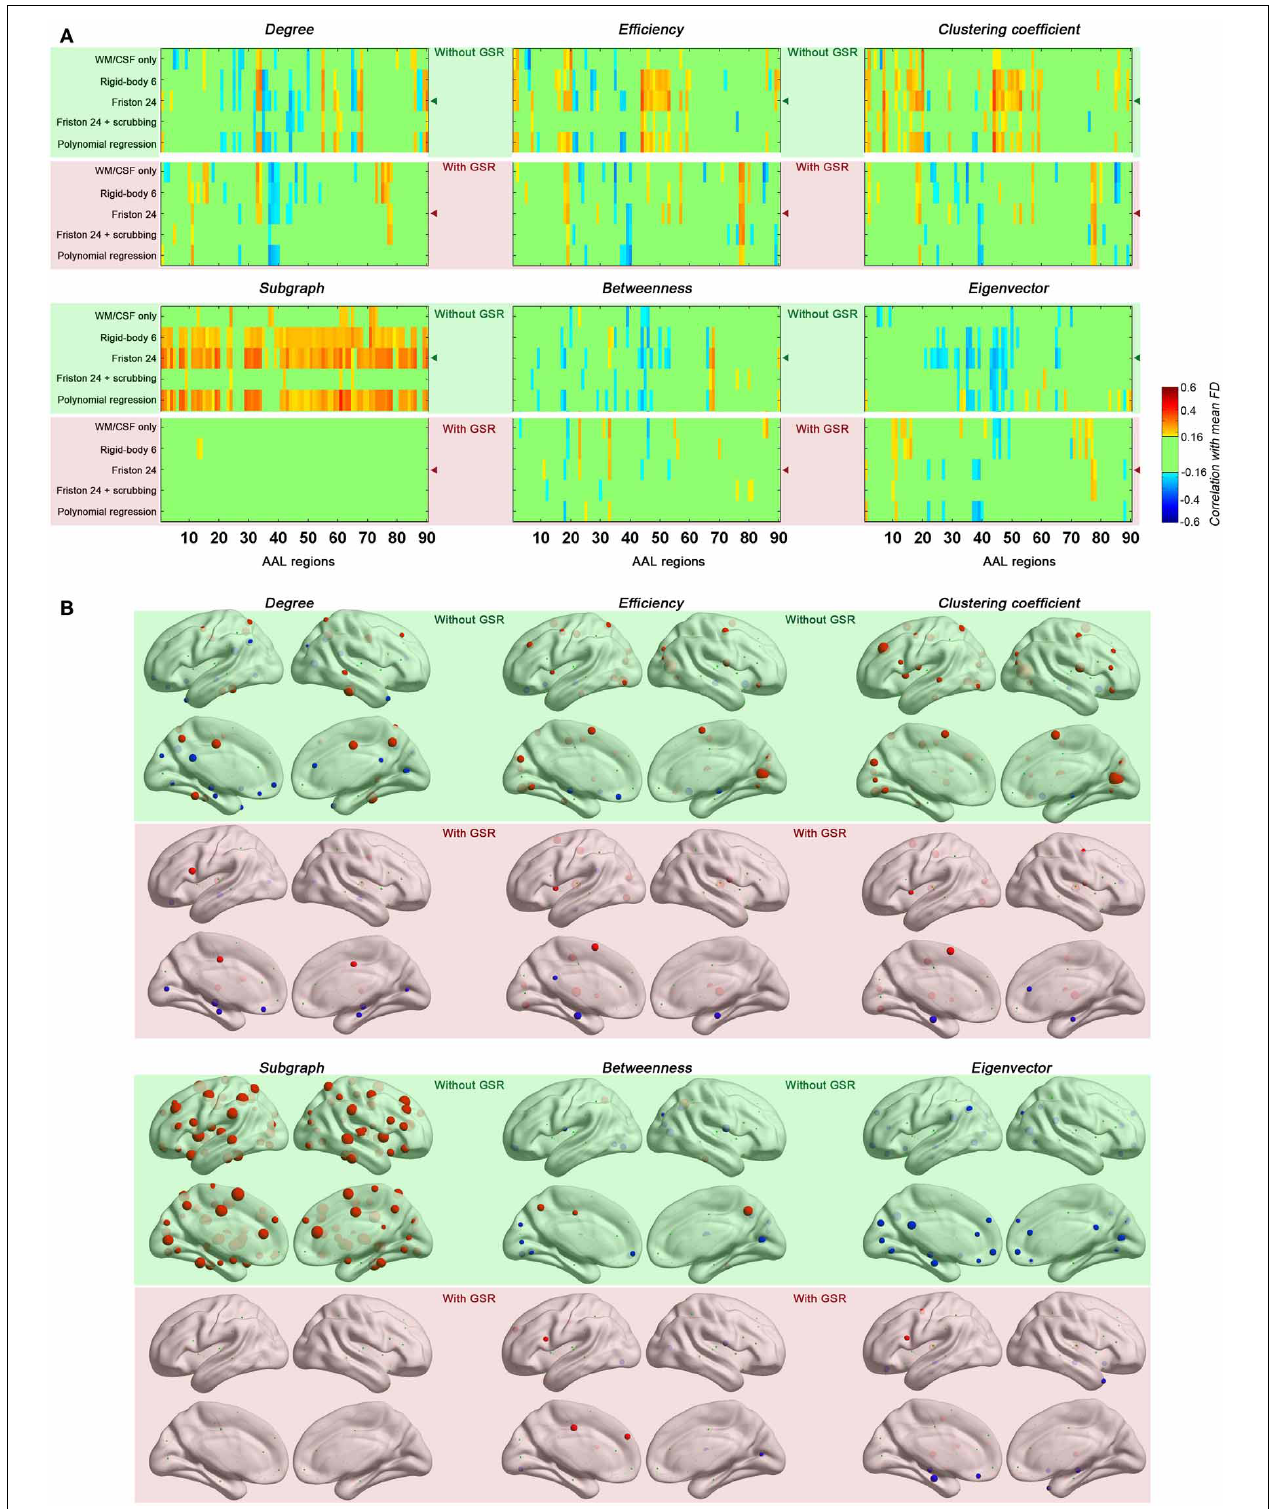
FIGURE 5 | Correlations between head motion and regional topological properties were plotted in matrix (A) and on brain surface (B). The layout of panel (A) is the same as Figure 4 except that each column represents one of the AAL regions. The regional properties were characterized by the area